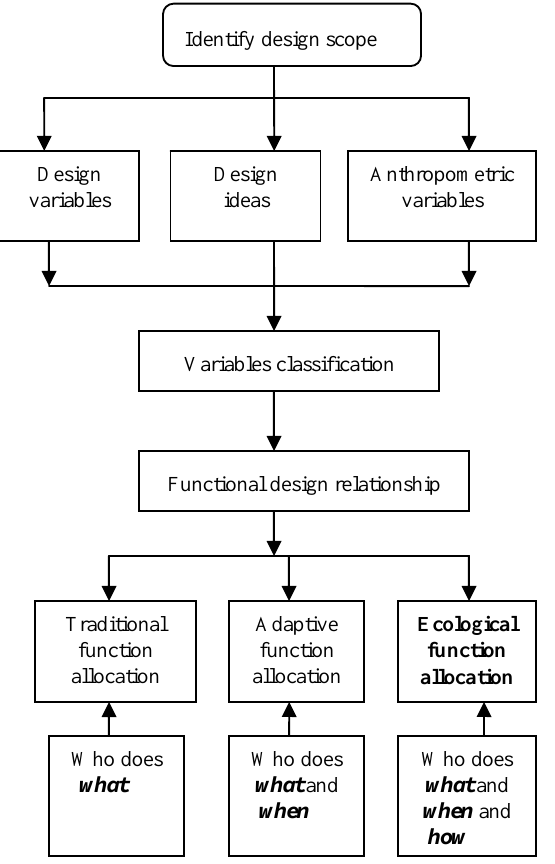
Fig. 4. Systematic design structure for function allocations (iii)correlation analysis of driving tasks and driving cognitive behaviour, (iv)development of functional design relationship (intra- relationship analysis of ergonomic, mechanical and aesthetic design variables), (v)integration and design of human factors in driver- vehicle